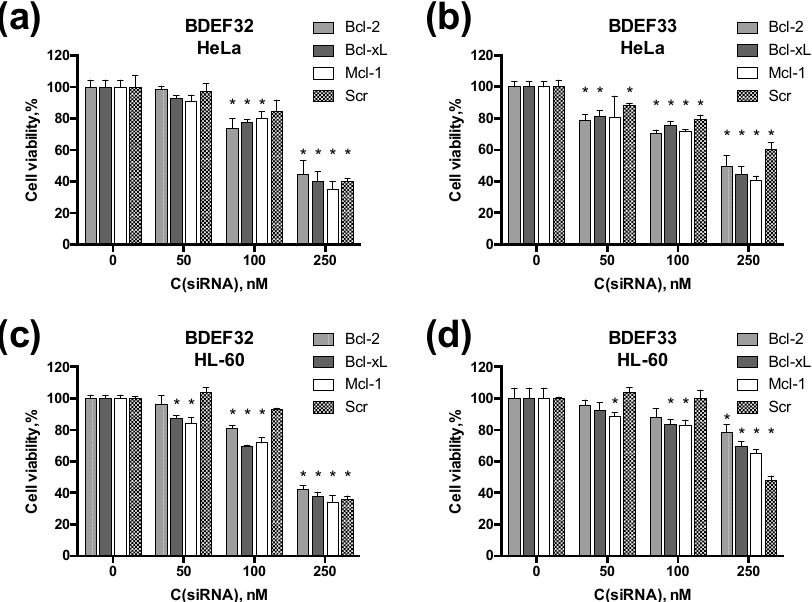
Figure 8. Cytotoxicity of dendriplexes. Viability of HeLa cells treated with dendriplexes formed by ( a ) BDEF32 and ( b ) BDEF33 and pro-apoptotic siRNAs, as measured by the MTT assay. Viability of HL-60 cells treated with dendriplexes formed by ( c ) BDEF32 and ( d ) BDEF33 and pro-apoptotic siRNAs, as measured by spectrofluorimetric resazurin assay (SRA). Molar ratio of [dendrimer]/[siRNA] = 10. Viability of the cells was evaluated (% relative to the negative control) after 72 h of incubation with dendrimers and siRNAs. * indicates statistically significant differences ( p < 0.05) from untreated cells.